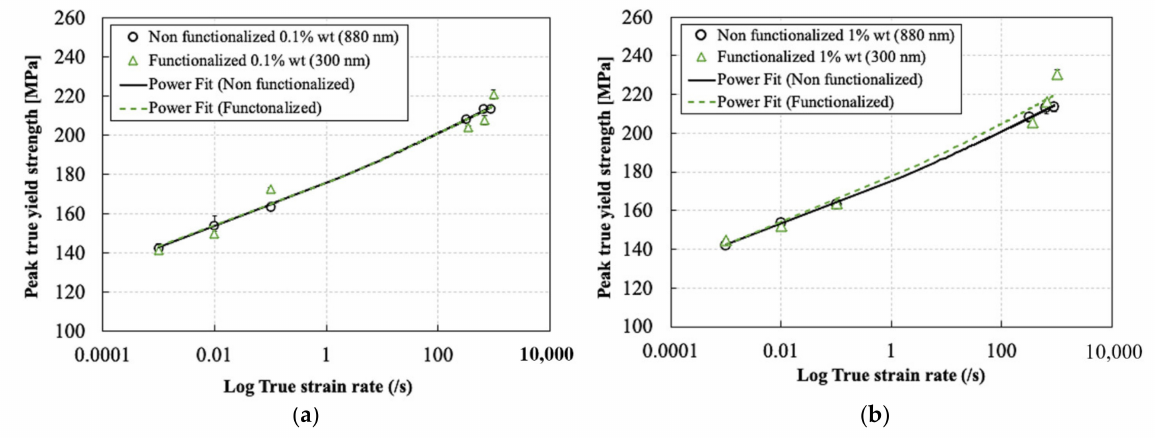
Figure 12. Effect of silica nanoparticles size and surface functionalization on the compressive true peak yield strength: ( a ) 0.1% and ( b ) 1%.